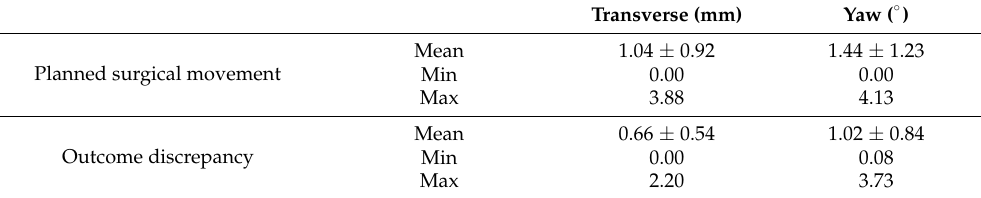
Table 1. Translational movement of the A-point and angular change of the maxilla in the transverse axis.